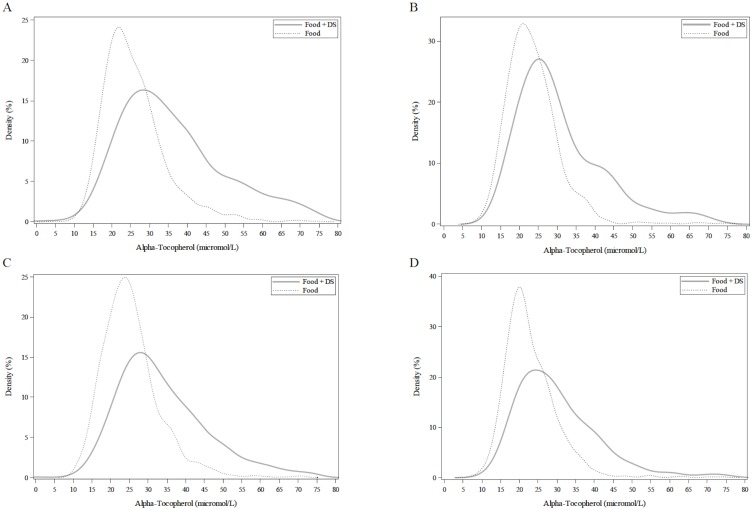
Distribution of serum α-tocopherol concentrations among individuals ≥20y, excluding pregnant or lactating women, stratified by race-ethicity and supplement.A. Non-Hispanic White. B. Non-Hispanic Black. C. Mexican American. D. Other. Lines represent density (as a percentage) through non-parametric kernel density estimation.